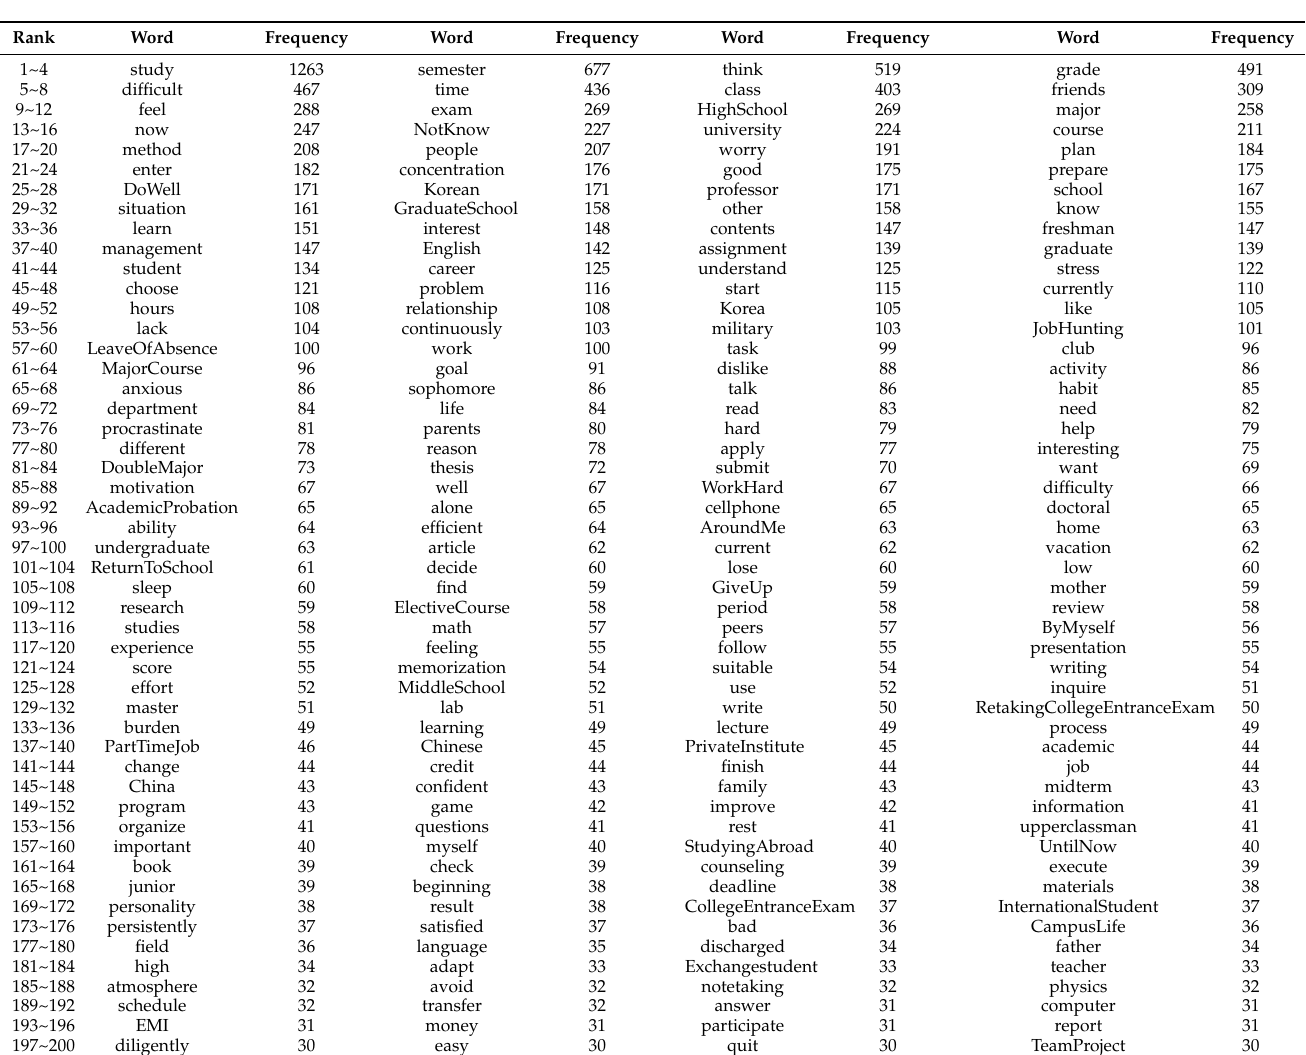
Table A3. Keywords before COVID-19 (2017–2019) with frequency of 30 or